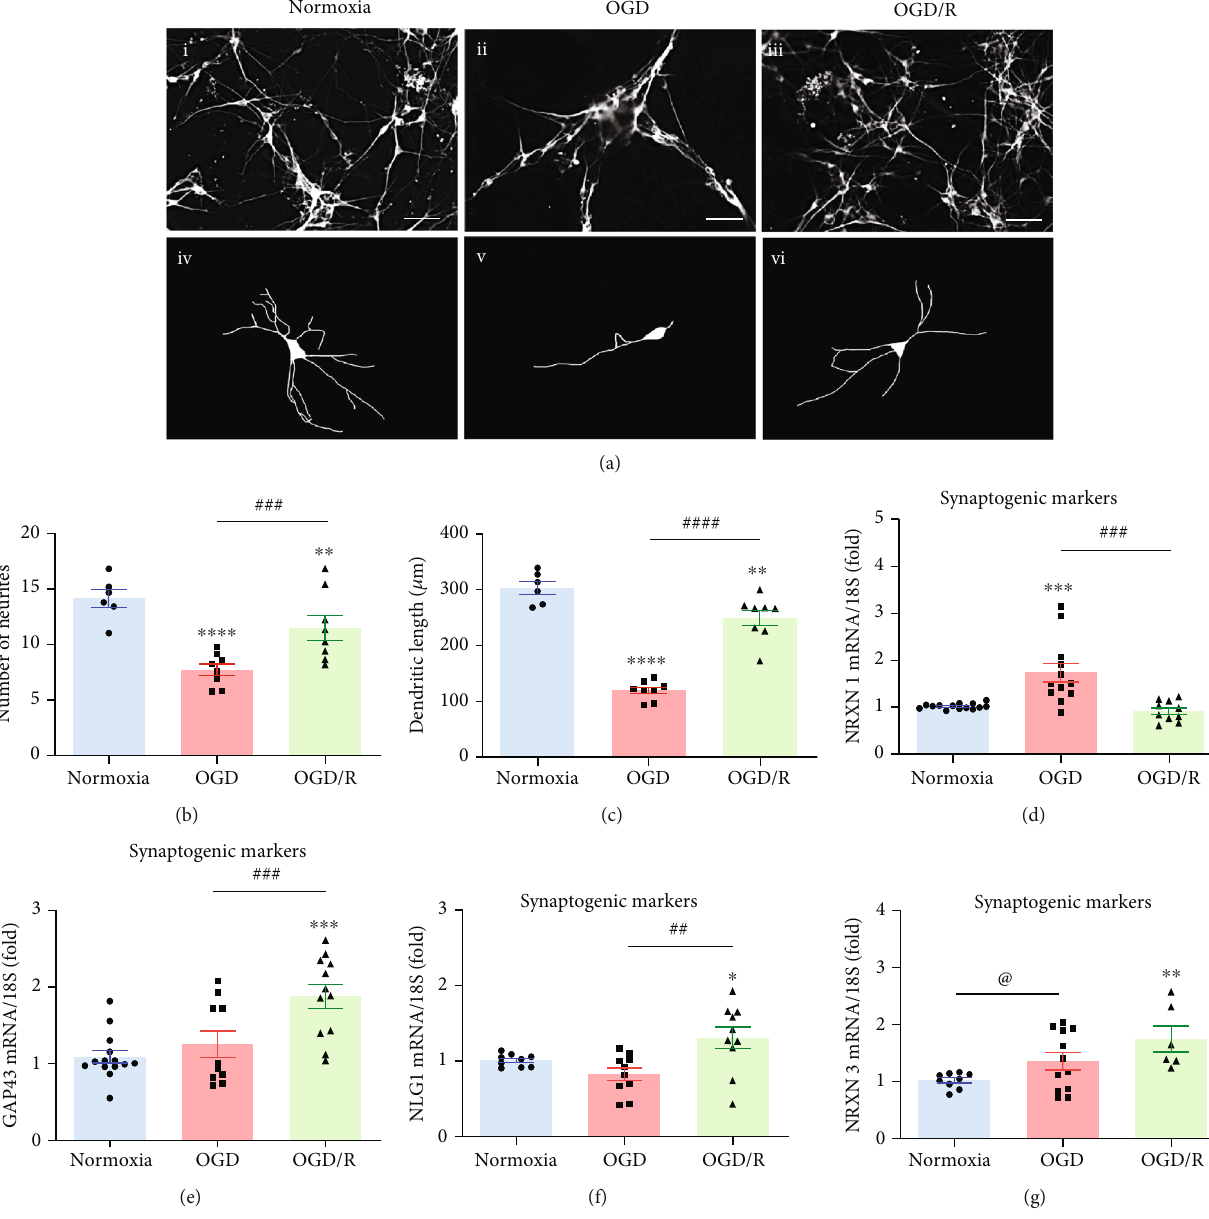
Figure 3: E ff ects of OGD and reoxygenation (OGD/R) on neurite outgrowth and expression of synaptogenic markers. (a) Representative microphotographs of hippocampal cultures in each experimental group are shown. (i-iii) Neurons stained with β -III-tubulin. Scale bar: 50 μ m. (iv-vi) Schematic drawings from β -III-tubulin-IR neurons used for morphometric analysis. (b) The number of neurites was evaluated in 10 individual neurons for each experimental group. (c) For dendritic length analysis, individual neurons were selected and drawn using the Simple Neuro Tracer software. Lower panels show the relative expression of (d) NRXN 1, (e) NRXN 3, (f) NLG1, and (g) GAP43 mRNAs, as determined by RT-qPCR. Relative mRNA expression values were corrected by the comparative threshold cycle (Ct) method and employing the formula 2 − ΔΔ CT . Ribosomal 18S RNA was used as housekeeping gene. Bars represent mean ± SEM . Asterisks ( ∗ ) indicate signi fi cant di ff erences in comparison to control ( ∗ p < 0 : 05 ; ∗∗ p < 0 : 01 ; ∗∗∗ p < 0 : 001 ; ∗∗∗∗ p < 0 : 0001 ), and number sign (#) shows di ff erences between experimental groups (# p < 0 : 05 ; ## p < 0 : 01 ; ### p < 0 : 001 ; #### p < 0 : 0001 ) as assessed by one-way ANOVA and Tukey as posthoc test. An unpaired Student ’ s t -test was used to compare normoxia versus OGD (g), and the at sign (@) indicates a signi fi cant di ff erence (@, p < 0 : 05